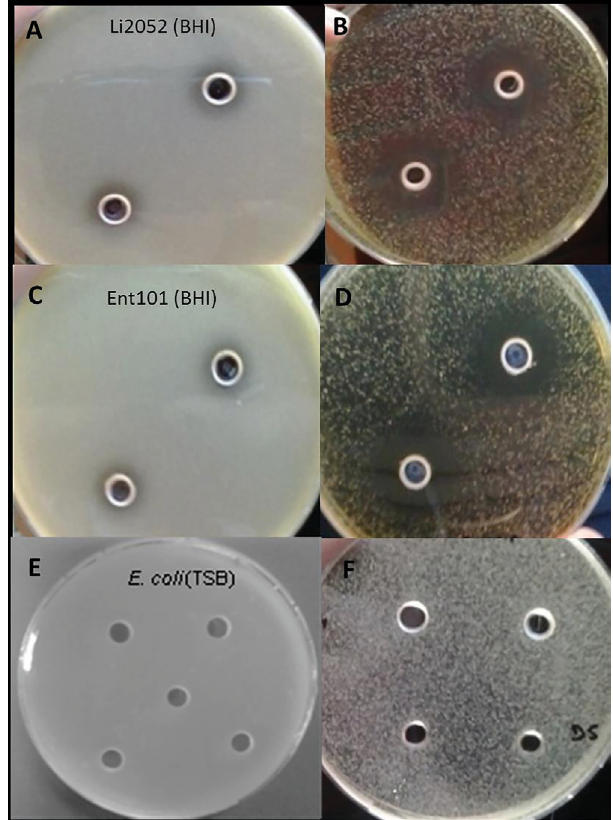
Legend: G-MRS = glucose-based MRS medium, GS-MRS = glucose + sucrose-based MRS medium, GI-MRS = glucose + inulin- based MRS medium, S-MRS = sucrose-based MRS medium, I-MRS = inulin-based MRS medium, GSI-MRS = glucose + sucrose + inulin-based MRS medium. Mean values (n=3) ± standard deviations. Different letters in the same column mean that values significantly differ among them ( p ˂ 0.05)